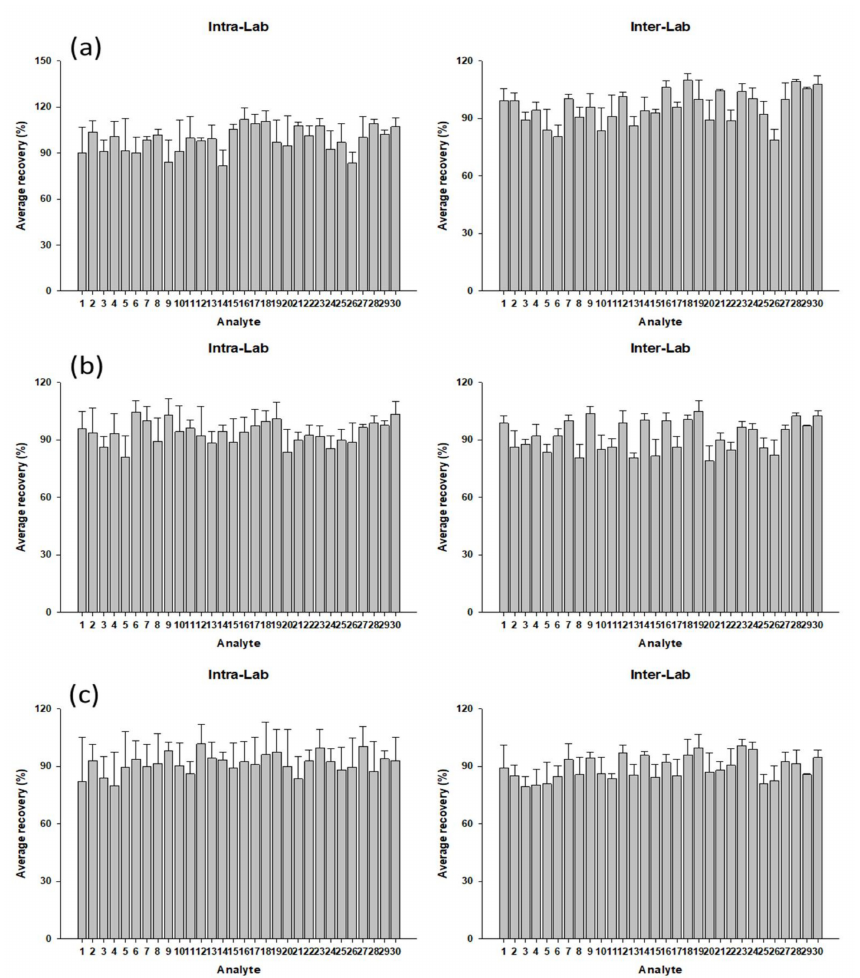
Figure 4. The average recoveries of 30 veterinary drugs intra-lab and inter-lab in ( a ) corn feed, ( b ) cow feed, and ( c ) pet feed ( n = 5). Veterinary drug name: (1) amprolium; (2) bacitracin; (3)